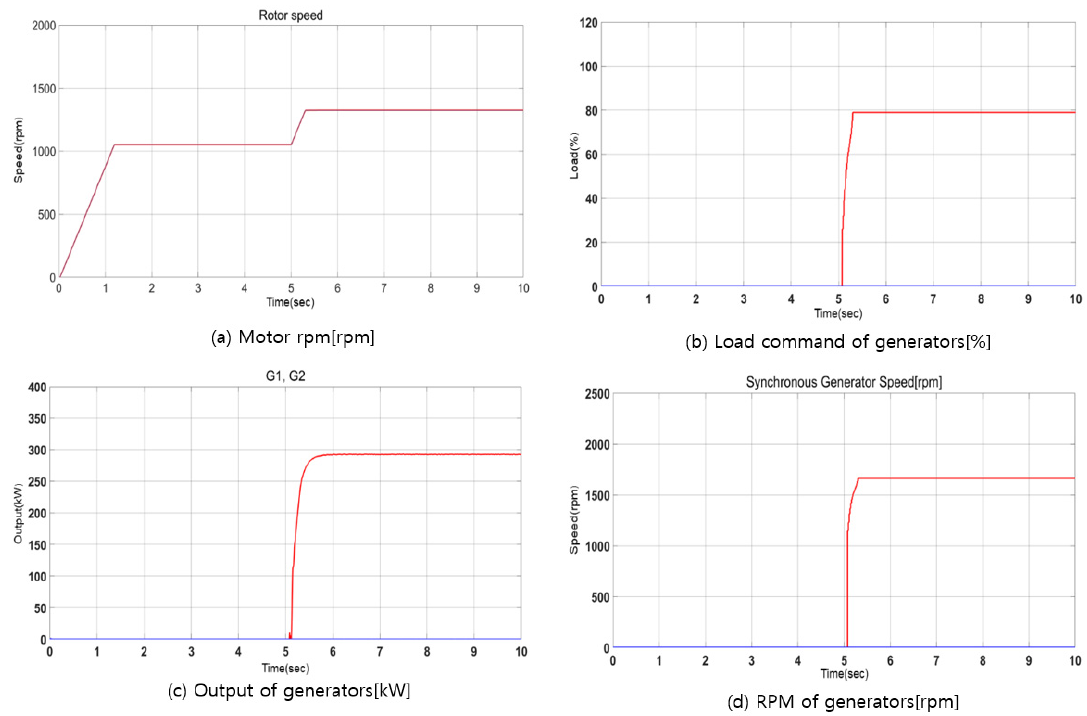
Figure 20. Simulation results of propulsion motor and generators when load varies as 20 → 40%.